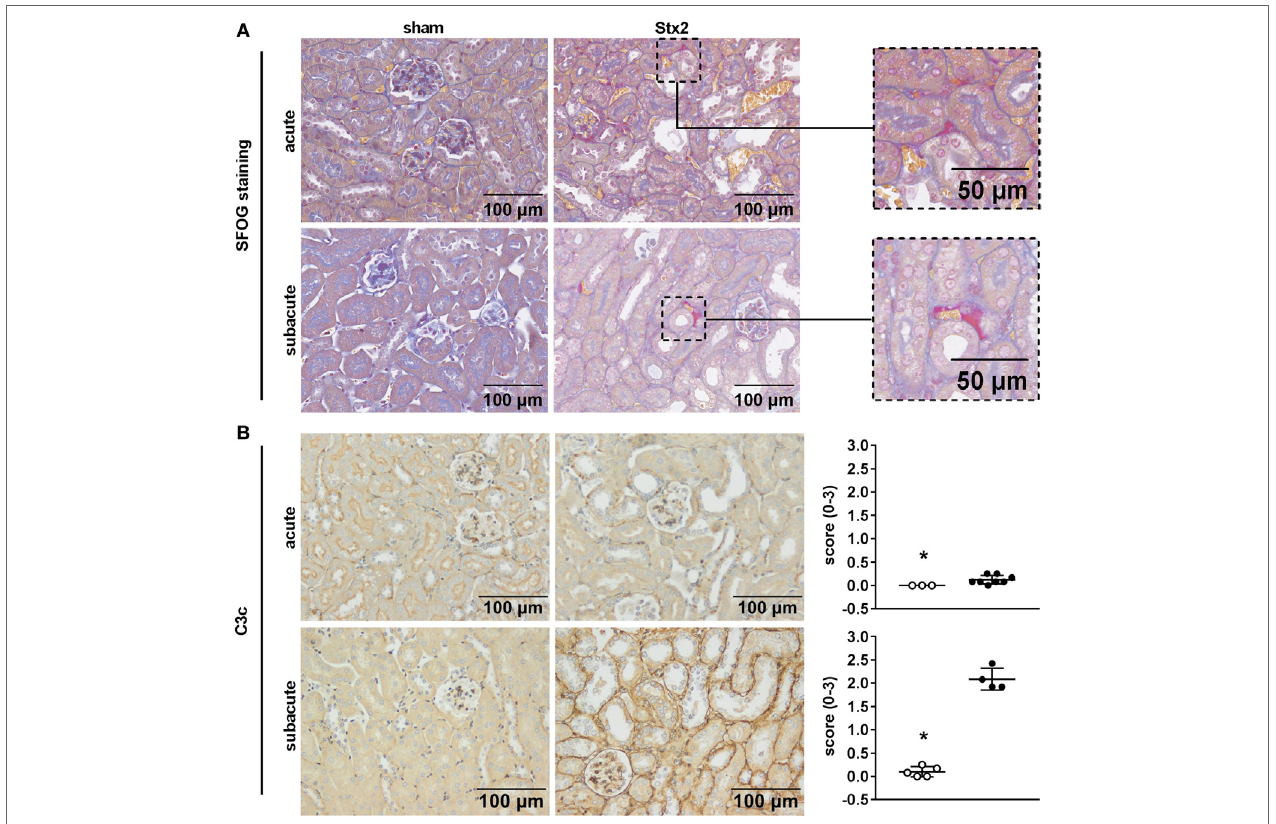
FigUre 8 | Indicators of thrombus formation and complement activation in C57BL/6J mice subjected to different Stx2 regimens. (a) Representative images (scale bar 100 µm) of SFOG staining in renal sections. Thrombus formation was observed in Stx2 groups of both models (see zoomed areas on the right, scale bar 50 µm). (B) Representative images (scale bar 100 µm) of immunohistochemical detection and quantification of C3 and C3b complement deposition by C3c staining in renal sections of C57BL/6J wild-type mice are depicted (acute: sham n = 3, Stx2 n = 8; subacute: sham n = 5, Stx2 n = 4). * p < 0.05 for sham (white dots) vs. Stx2 (black dots; Mann–Whitney U